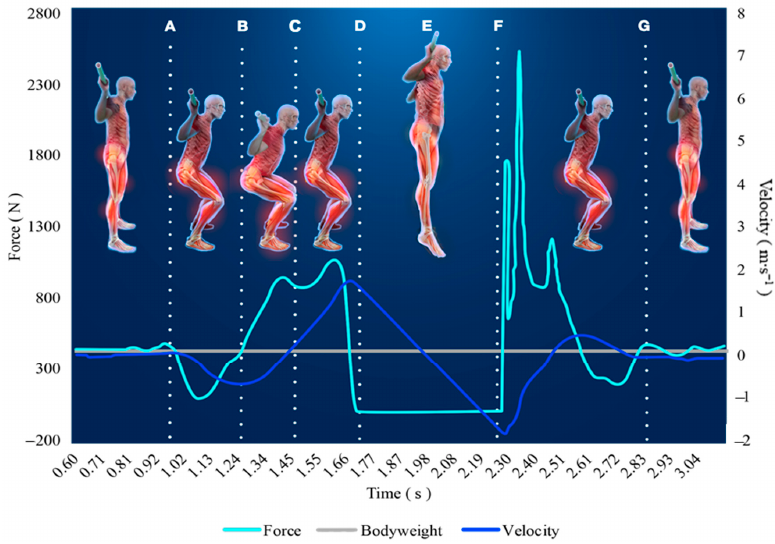
Figure 3. This is an example of a force-time curve from a countermovement jump (CMJ). The weighing phase occurs for at least one second prior to initializing movement (point A). The individual begins descent (i.e., eccentric action) resulting in an initial drop in the forces, known as the unweighting phase, until bodyweight is reached (point B). The individual must decelerate through the remainder of the eccentric phase until velocity reaches zero (point C), known as the braking phase. The individual then explodes upwards until take-off (point D), reaching maximal jump height approximately half way through the flight phase (point E), and eventually landing (point F). The landing phase then begins until a stabilization period is reached (point G). Int. J. Environ. Res. Public Health 2020 , 17 , x